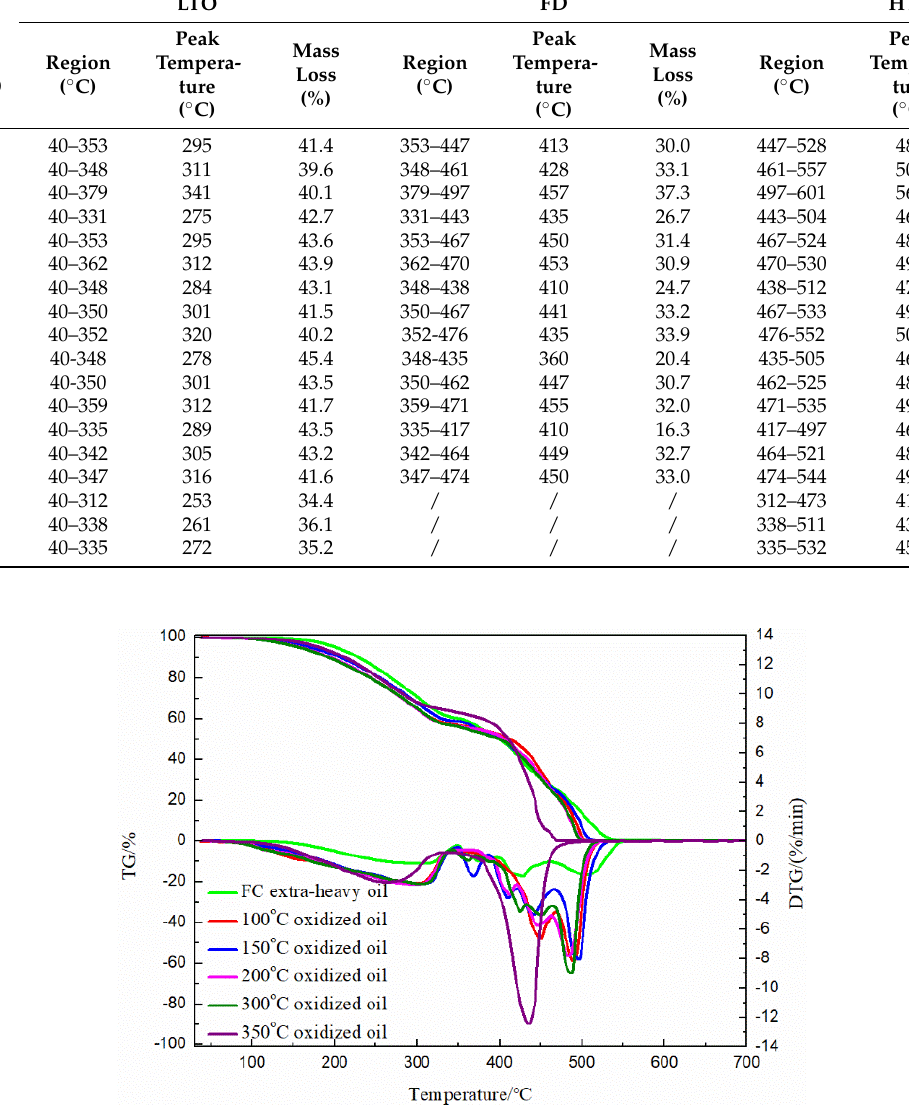
Figure 8. To better understand the exothermic behavior of all oil samples, the oxidation reaction region was divided into an LTO interval and an HTC stage in the DSC curves. The characteristic parameters obtained from the DSC curves of FC extra-heavy oil and oxidized oils are listed in Table 5. Compared to FC extra-heavy oil, the termination temperatures of each oxidized oil were lower than 550 ◦ C, especially in the 350 ◦ C oxidized oil. This may mean that the 350 ◦ C oxidized oil has better combustion performance during the HTC